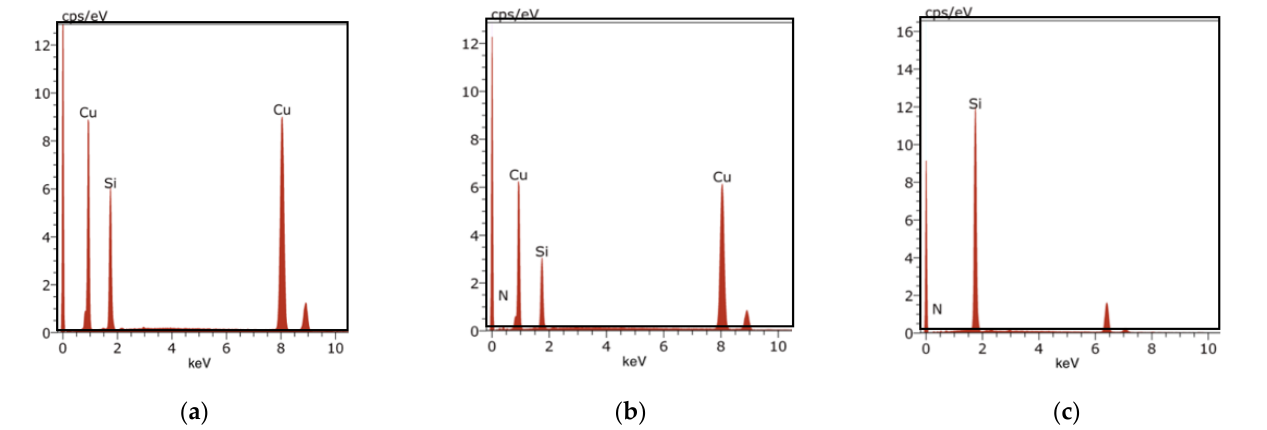
Figure 5. EDX analysis of ( a ) Si@Cu, ( b ) Si 3 N 4 @Cu, and ( c ) Si 3 N 4 @Si@Cu films.